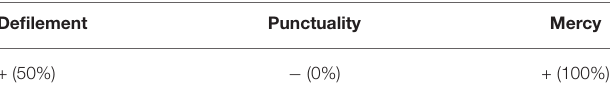
TABLE 2 | The probabilities resulted from helping the half-dead stranger with leprosy a . Defilement